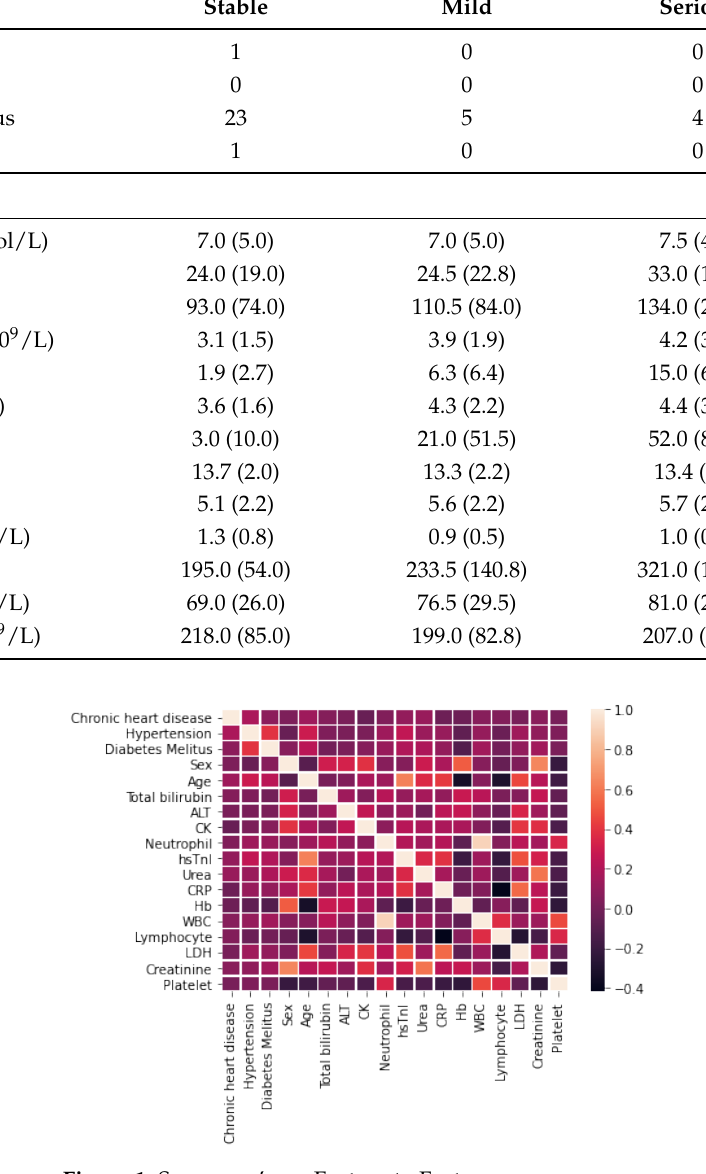
Figure 1. Spearman’s ρ —Feature to